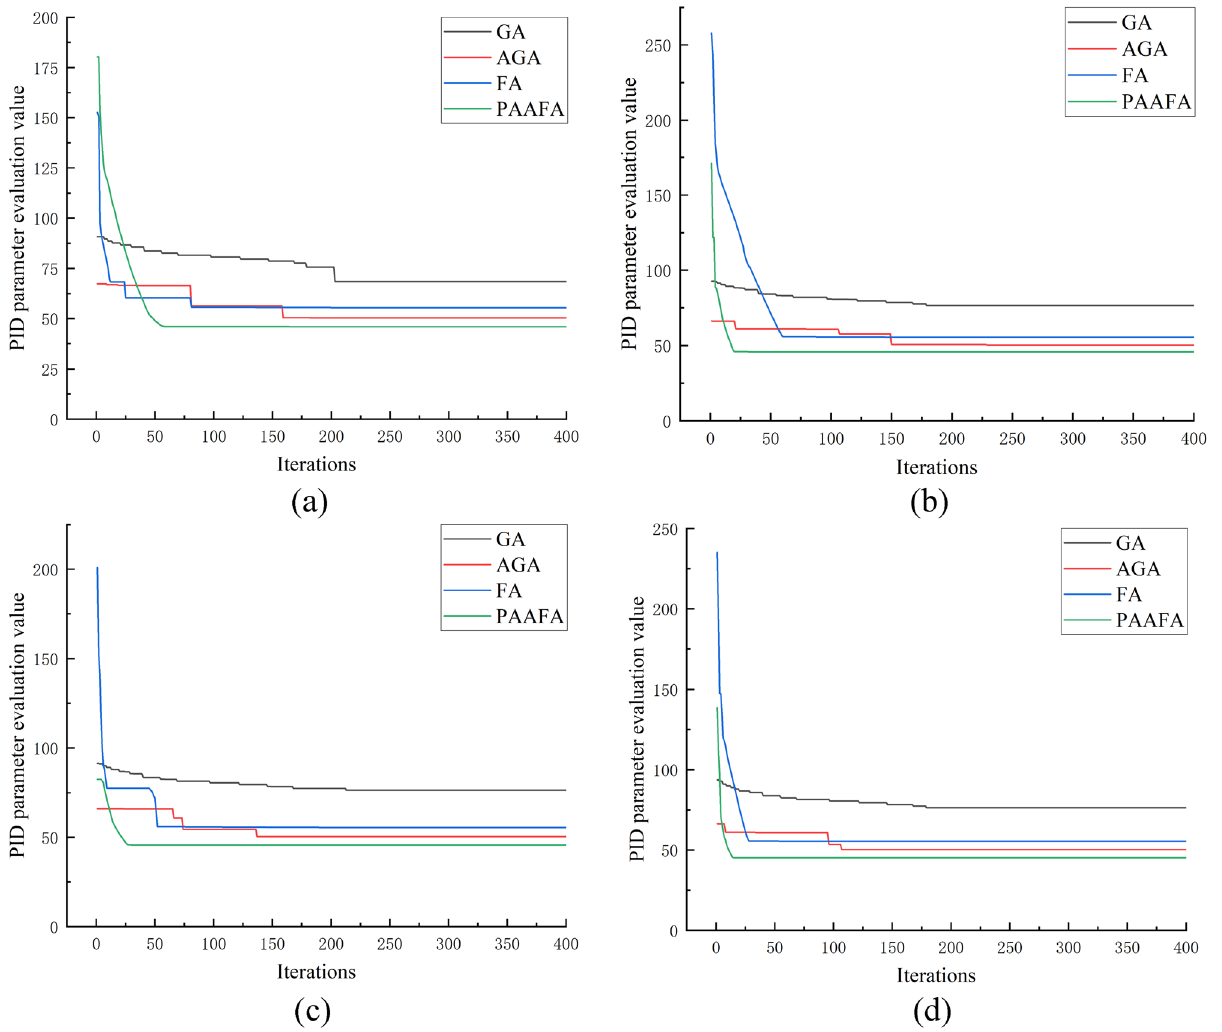
Figure 4. Comparison of PID parameter evaluation values for three algorithms: ( a ) population size of 30; ( b ) population size of 50; ( c ) population size of 70; ( d ) population size of 90.